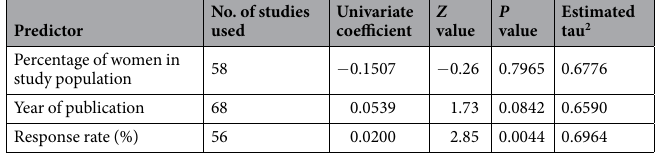
Table 1. Results for meta-regression on studies on point prevalence of depression.